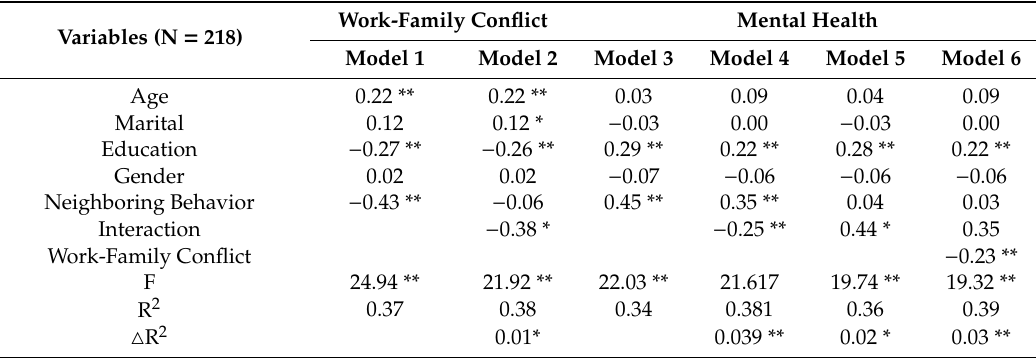
Table 4. Hierarchical Linear Regression Analysis